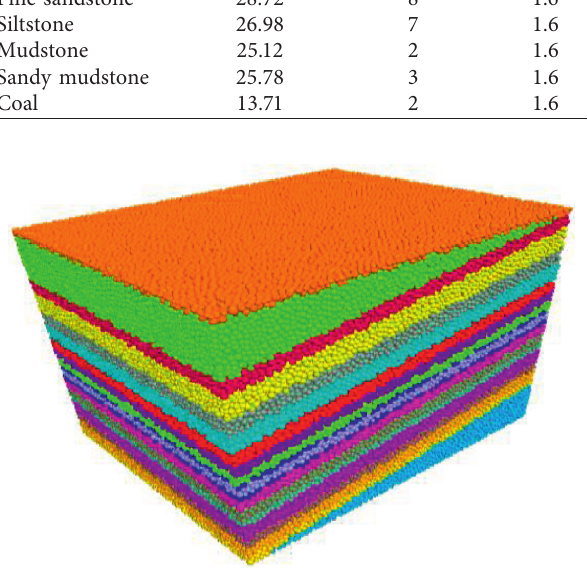
Figure 4: Three-dimensional numerical